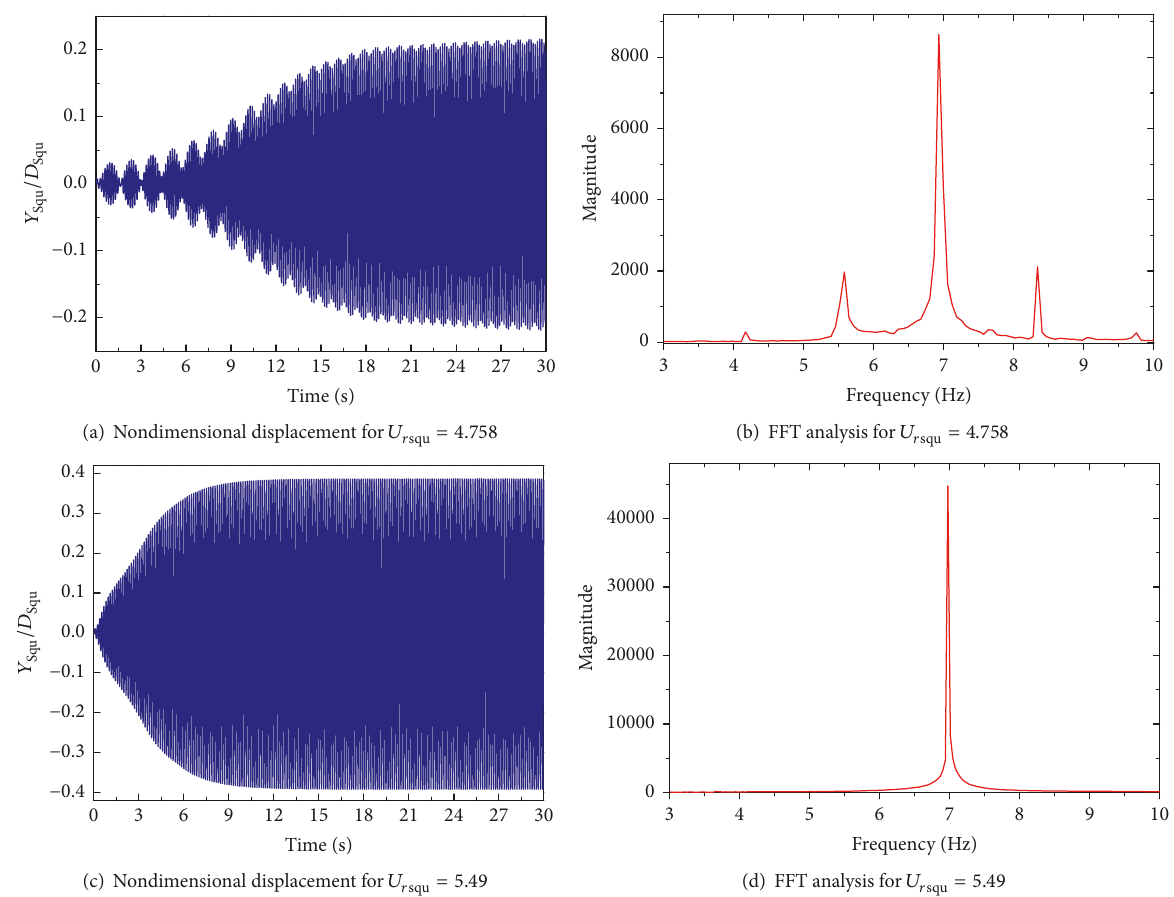
(c) Nondimensional displacement for 𝑈 𝑟 squ = 5.49 (d) FFT analysis for 𝑈 𝑟 squ = 5.49